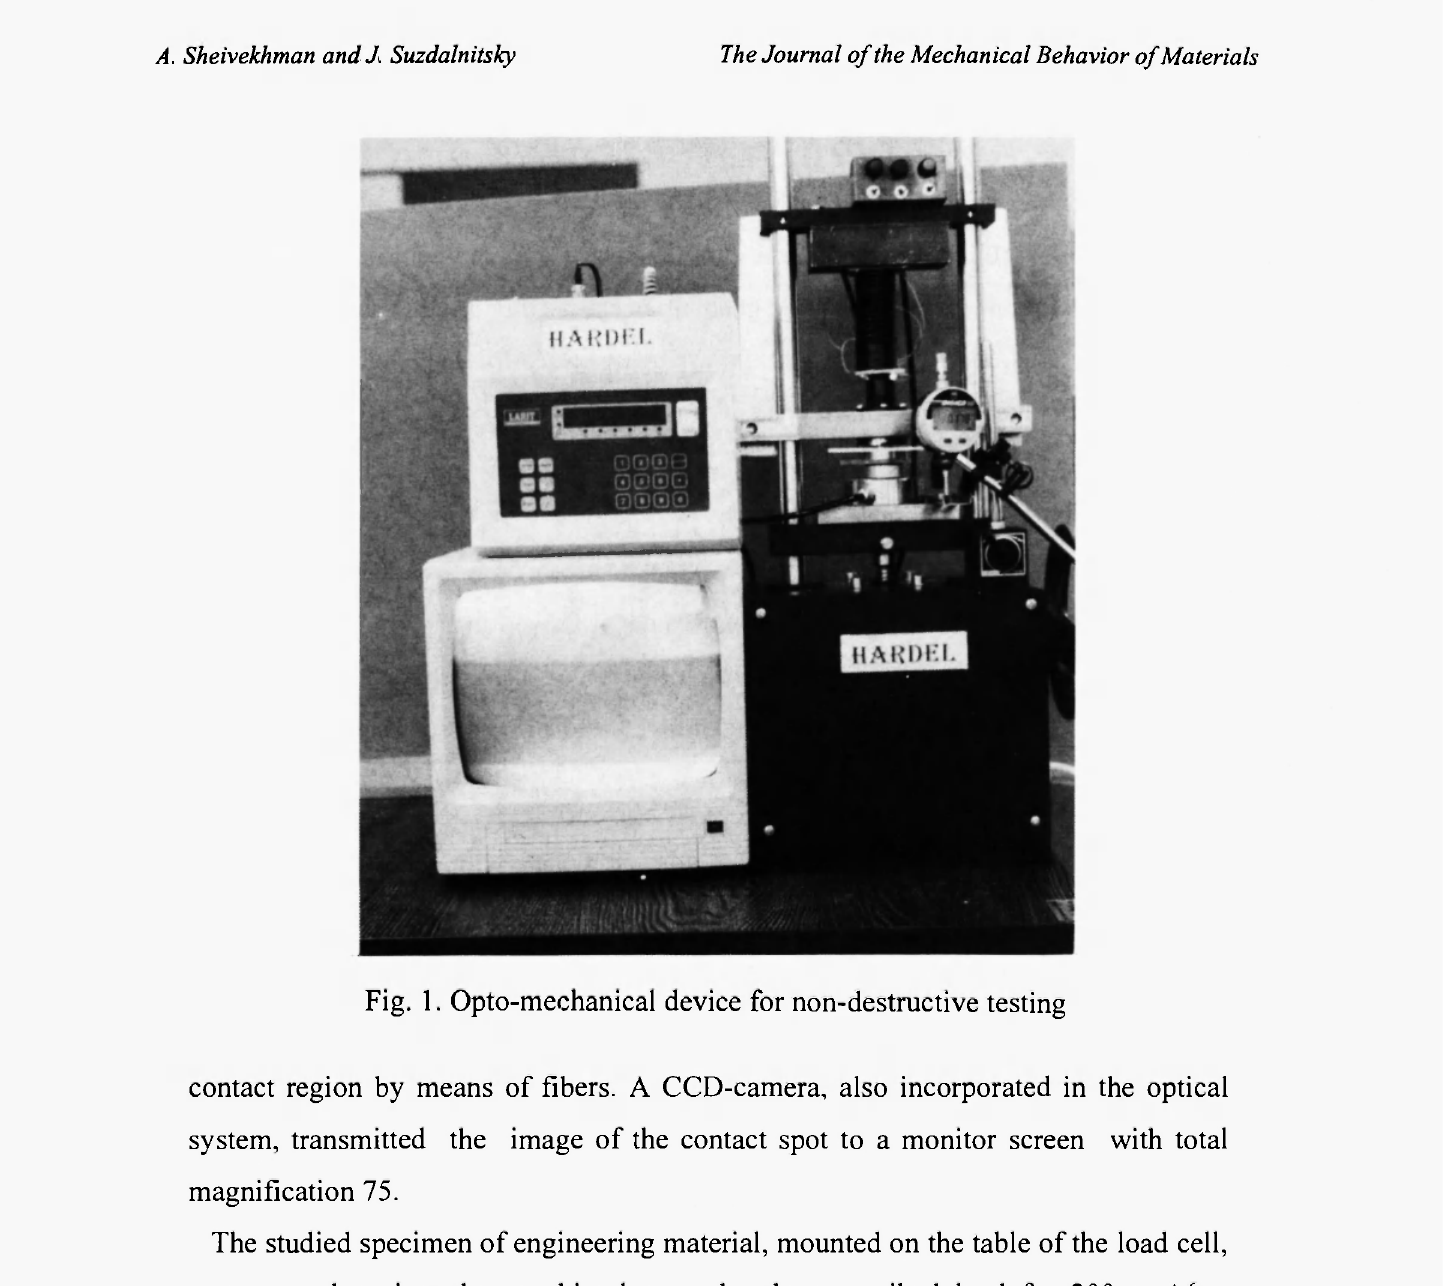
Fig. 1. Opto-mechanical device for non-destructive